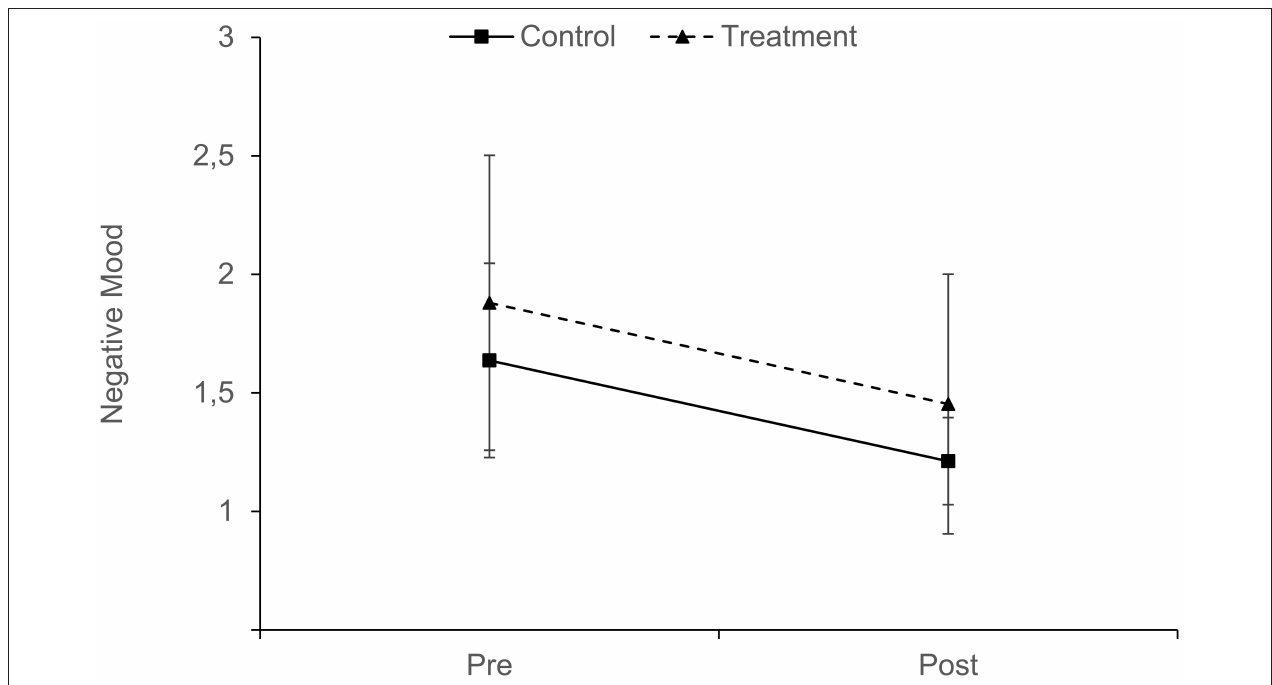
FIGURE 6 | Negative mood by condition by time point. Error bars represent 95% CI.